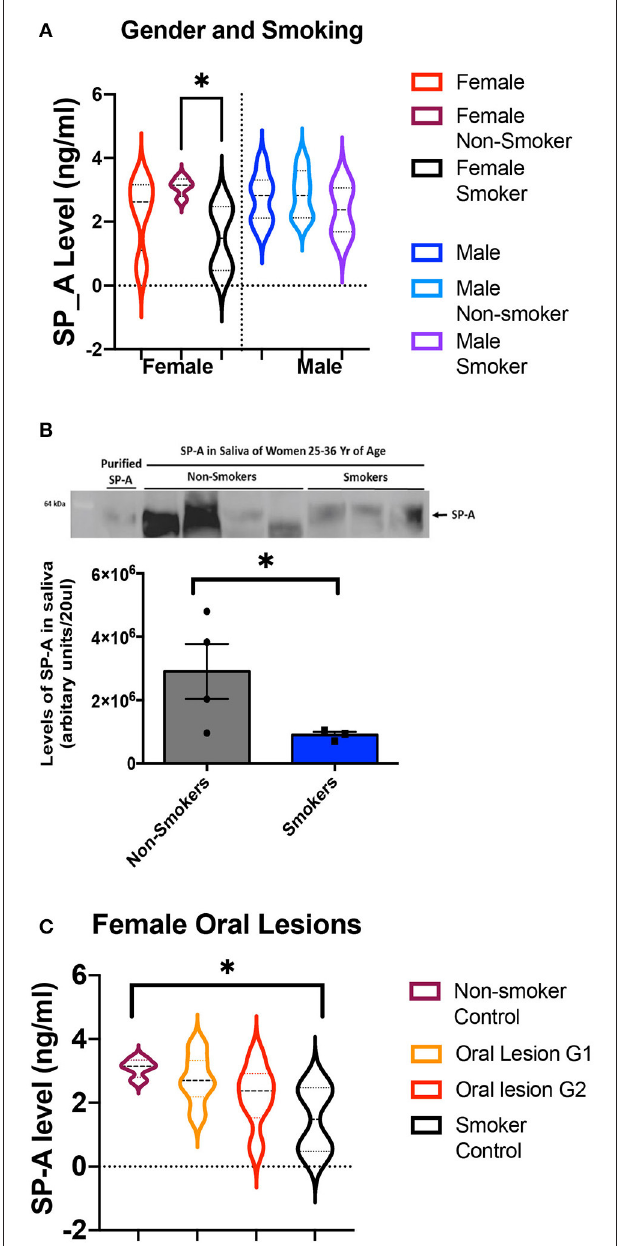
FIGURE 1 | (A) ELISA values of salivary SP-A in controls, sub-divided by gender and by smoking habits. The levels of salivary SP-A are shown first for all controls and then split into non-smokers and smokers. Values for female subjects are shown on the left, and male subjects are shown on the right. There are eight female controls, split into four non-smokers and four smokers. There are eight male controls, split into five non-smokers and two smokers. The female non-smokers and female smokers have significantly different salivary SP-A levels ( p = 0.03) as assessed by Mann-Whitney. No other comparisons were significant. (B) SP-A levels in non-smoker and smoker females are significantly different as measured by western blot. The quantification of band intensities is represented below the western blot. An asterisk denotes the statistically significant difference between the samples.